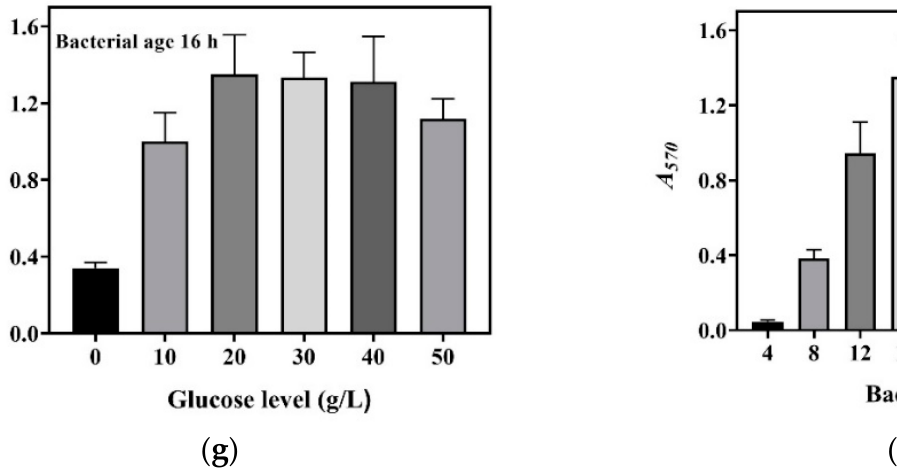
Figure 3. Effects of temperature on whole-cell catalysis. The relative content of GABA is expressed as A 570 ( n = 3). A 570 , absorbance at 570 nm. 3.3. Effects of Wet Cell Level on Whole-Cell Catalysis Each cell functioned as a catalyst. Cell concentration should affect GABA synthesis efficiency. Therefore, the effect of cell concentration on whole-cell catalysis was examined.